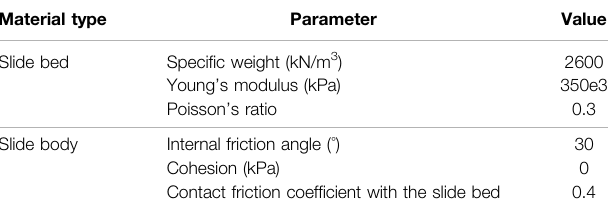
TABLE 1 | Suggested parameters for MPM calculations.